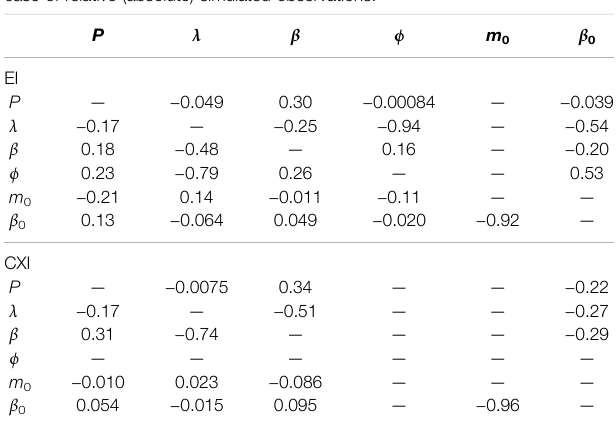
TABLE 9 | Correlation coef fi cients for the rotation period P (h), pole longitude λ ( ° ) and latitude β ( ° ), rotational phase ϕ ( ° ), and phase-curve parameters m 0 (mag) and β 0 (mag/rad) for MCMC lightcurve inversion using ellipsoids (EI for ellipsoid inversion) and convex shapes (CXI for convex inversion) in the case of the simulatedGSasteroid.Theupper(lower)trianglesdepictthecoef fi cientsinthe case of relative (absolute) simulated